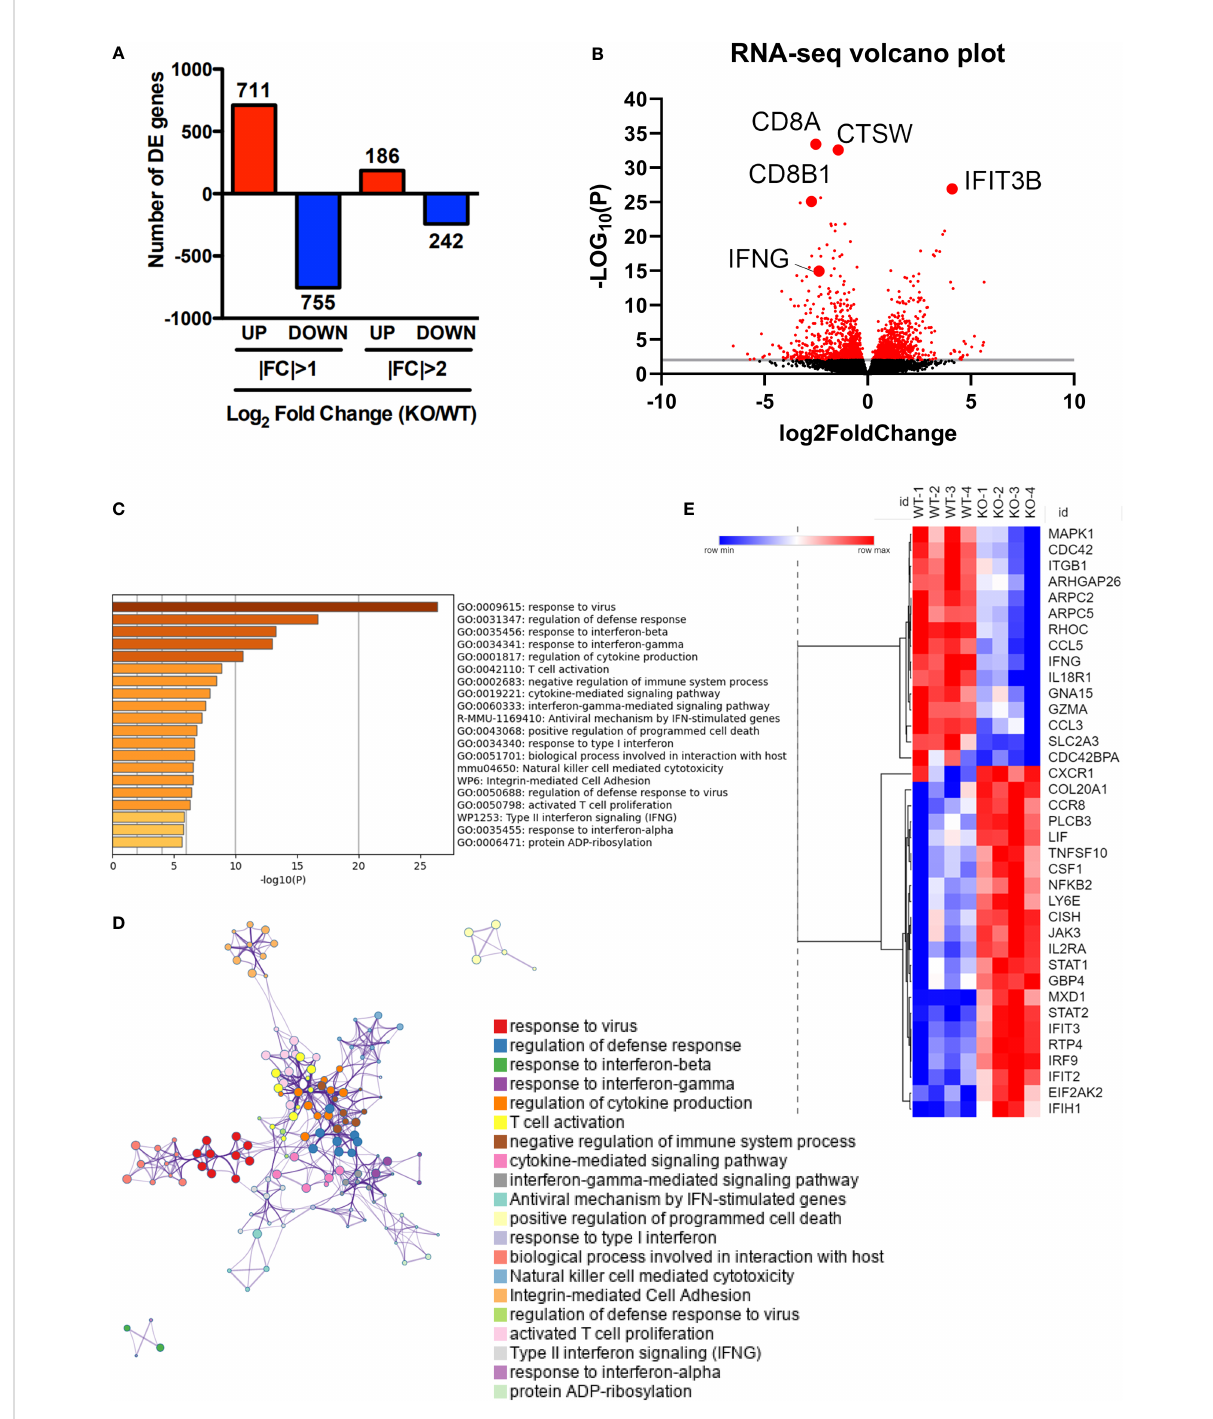
FIGURE 5 Transcriptomic pro fi ling reveals that SRSF1 controls antiviral cytokine signaling and apoptotic pathways in T cells. Total T cells were isolated from spleens of LCMV infected WT and KO mice (n=4/group). (A) RNA-sequencing data analysis shows differentially expressed (D, E) genes with log 2 fold change (F, C) differences at p<0.05. (B) Volcano plot showing upregulated and downregulated genes in KO T cells after LCMV infection compared to the WT. (C) Bar graph of top 40 enriched terms, colored by p-values. (D) GO terms enrichment map shows clusters of top 40 pathways. (E) Heat map showing average expression of selected DE genes associated with enriched